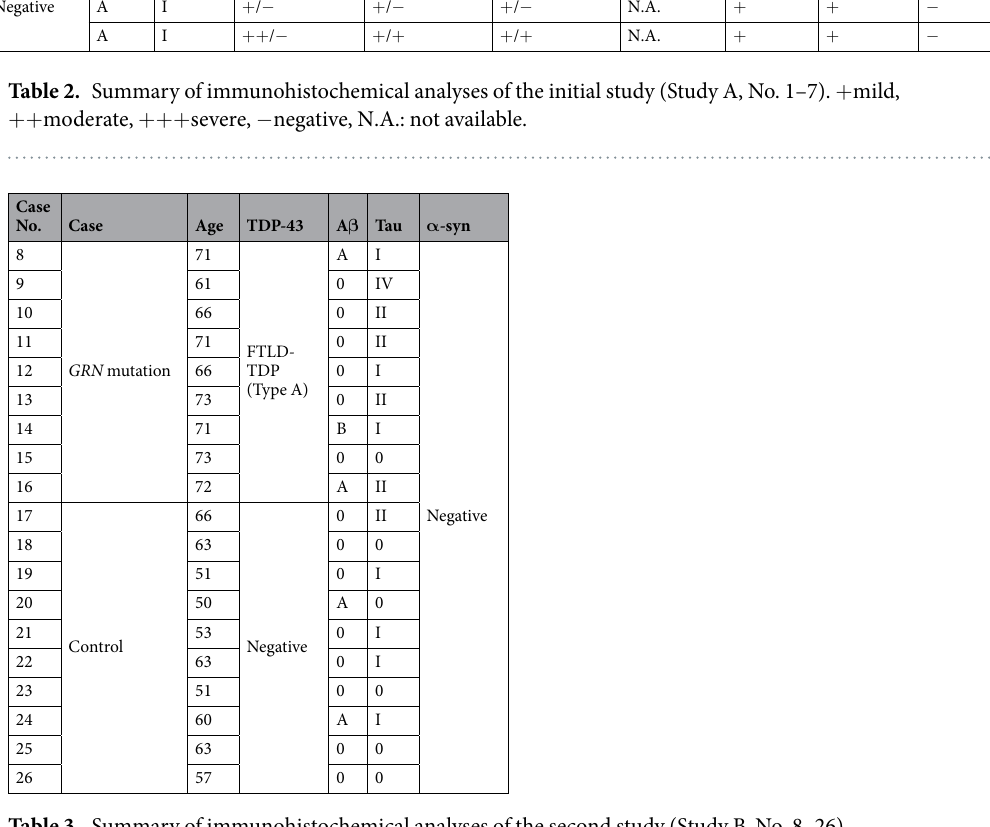
Table 3. Summary of immunohistochemical analyses of the second study (Study B, No.